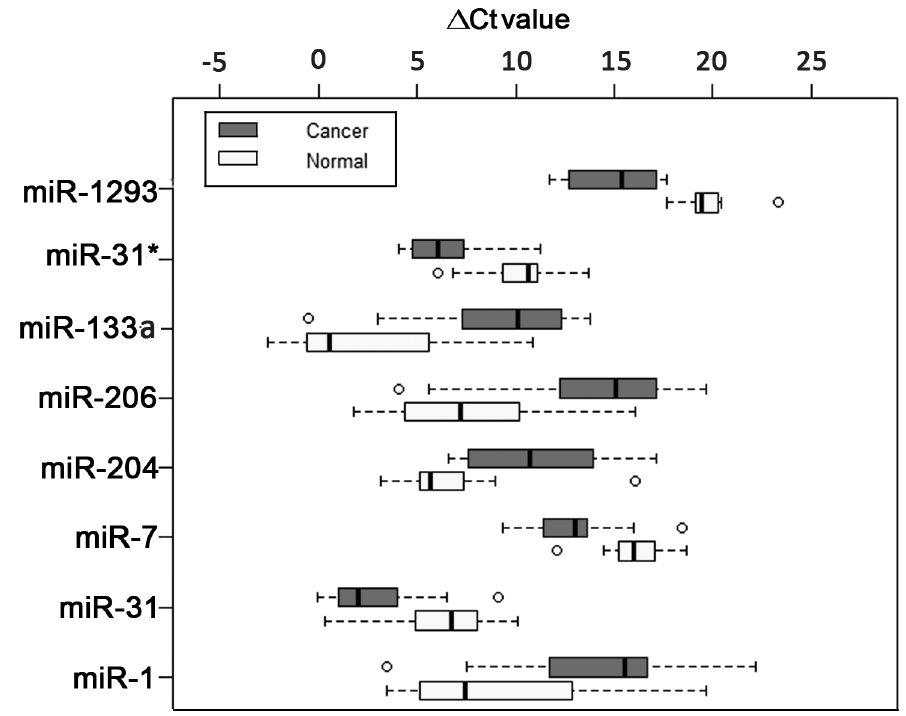
Figure 2. Forest plot showing expression variability of 8 miRNAs. Horizontal box plot is shown for distribution of expression ( D Ct) of miRNAs along the horizontal axis. P-values of miRNAs are plotted in ascending order (top to bottom). Expression of has-miR-1 is not significantly deregulated and shown to compare with those of other 7 miRNAs. Each Box and whisker pair (Gray for Cancer and white for Normal) represents range of variability of D Ct values for a miRNA from TLDA data. This range represents expression of all successfully assayed samples data for that miRNA.